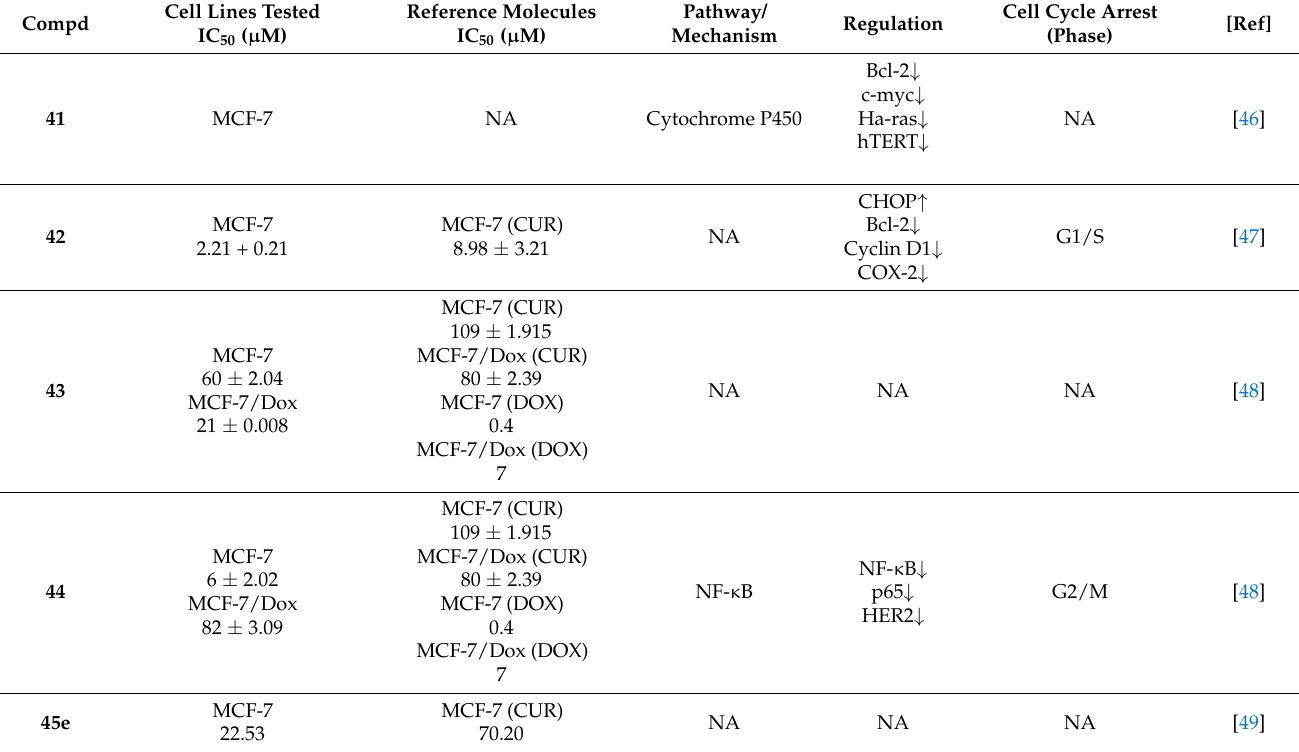
Table 3. Summarized information on curcumin